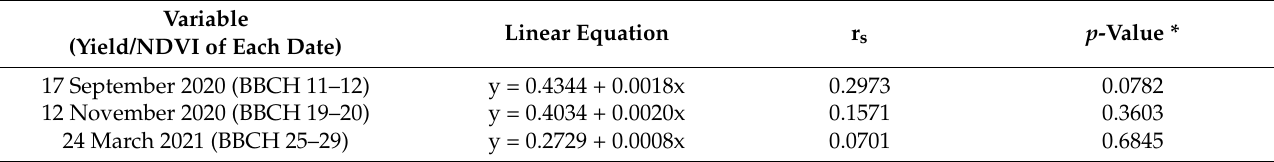
Table 7. Spearman’s rank correlation coefficients between final yield and normalized difference yellowness index (NDYI) values of each flight date during winter oilseed rape growing season